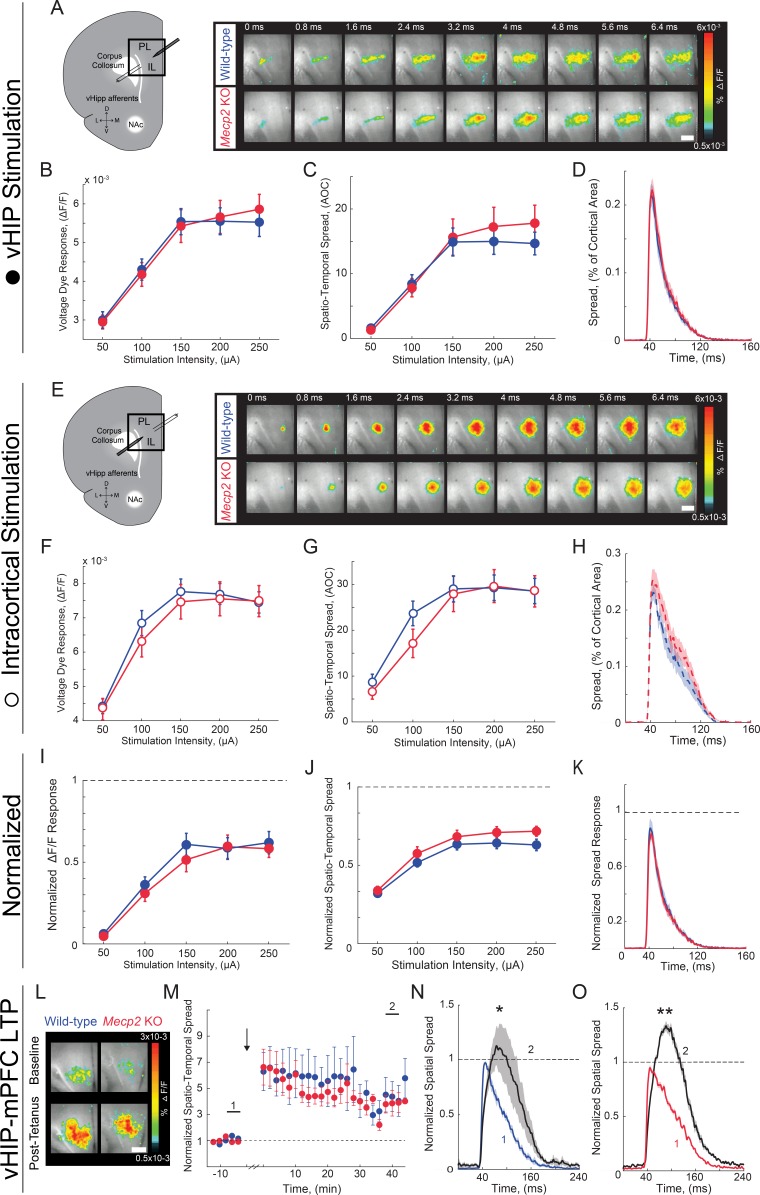
VSD responses to vHIP stimulation in mPFC slices and LTP at vHIP-mPFC synapses are not altered in presymptomatic Mecp2 KO mice.(A) Schematic of VSD imaging in an mPFC slice during stimulation of vHIP fibers and representative VSD responses evoked by a single vHIP fiber stimulation. Scale bar 100 µm. (B–D) Input-output relationships of VSD peak responses (B) p=0.424, Two-way ANOVA), spatiotemporal spread (C) p=0.625, Two-way RM ANOVA), and spread over time (D) p=0.2918 Student’s t-test) (at 150 µA intensity) evoked by a single vHIP fiber stimulation. (E) Schematic of VSD imaging in an mPFC slice during stimulation of intracortical fibers and representative VSD responses evoked by a single intracortical stimulation. (F–H) Input-output relationships of VSD peak responses (F) p=0.4663, Two-way ANOVA), spatiotemporal spread (G) p=0.3972, Two-Way RM ANOVA), and spread over time (H) p=0.2582, Student’s t-test) (at 150 µA intensity) evoked by a single intracortical stimulation. (I–K) Peak VSD responses (I) p=0.2278, Two-way RM ANOVA), spatiotemporal spread (J) p=0.5857, Two-way ANOVA), and spread over time (K) p=0.9145, Student’s t-test) evoked by a single vHIP fiber stimulation normalized to those evoked by a single intracortical stimulation. (A–K) n = 14 slices from five mice WT; n = 18 5 Mecp2 KO mice). (L) Representative images of peak VSD responses to a single test stimulation before and after high-frequency stimulation to induce LTP. (M) Normalized spatiotemporal spread of single test VSD responses before and after LTP induction; high-frequency stimulation given at arrow. (N–O) Spread over time of single test VSD responses at baseline (1) and 40 min after LTP induction (2), normalized to baseline peak spread in WT slices (N) p=0.0159, Wilcoxon paired test) and Mecp2 KO slices (o) p=2.165×10−5, Wilcoxon paired test) (L–N) n = 5 slices from 5 WT mice; n = 9/5 Mecp2 KO mice). Spatiotemporal spread is the AOC created by spread of the cortical area (% of total) and time (ms). Mean ± SEM; *p<0.05, **p<0.01.10.7554/eLife.44182.020Figure 4—figure supplement 2—source data 1.VSD responses to vHIP stimulation in mPFC slices of Mecp2KO mice do not develop in a typical manner.